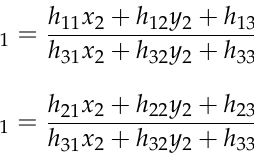
Figure 9. Transformation from world-corresponding points to sensor touch points in the image